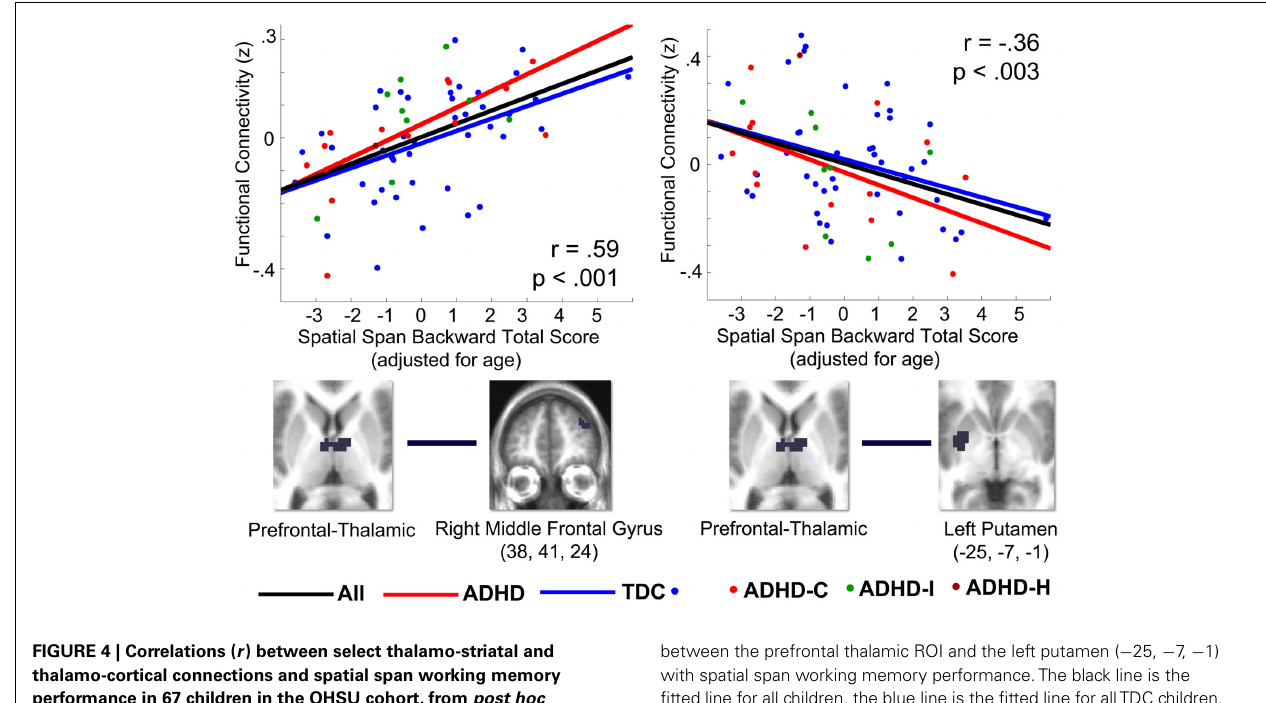
FIGURE 4 | Correlations ( r ) between select thalamo-striatal and thalamo-cortical connections and spatial span working memory performance in 67 children in the OHSU cohort, from post hoc analysis. Graphs plot z -transformed functional connectivity values on the y -axis with adjusted spatial span backward total scores on the x -axis. Spatial span backward total scores were covaried for age.The Pearson correlation coefficient ( r ) and significance are displayed for each graph. The ROIs used to generate the correlation are visualized below each graph.The left graph plots connectivity between the prefrontal thalamic ROI and the right middle frontal gyrus (38, 41, 24) with spatial span working memory performance.The right graph plots connectivity